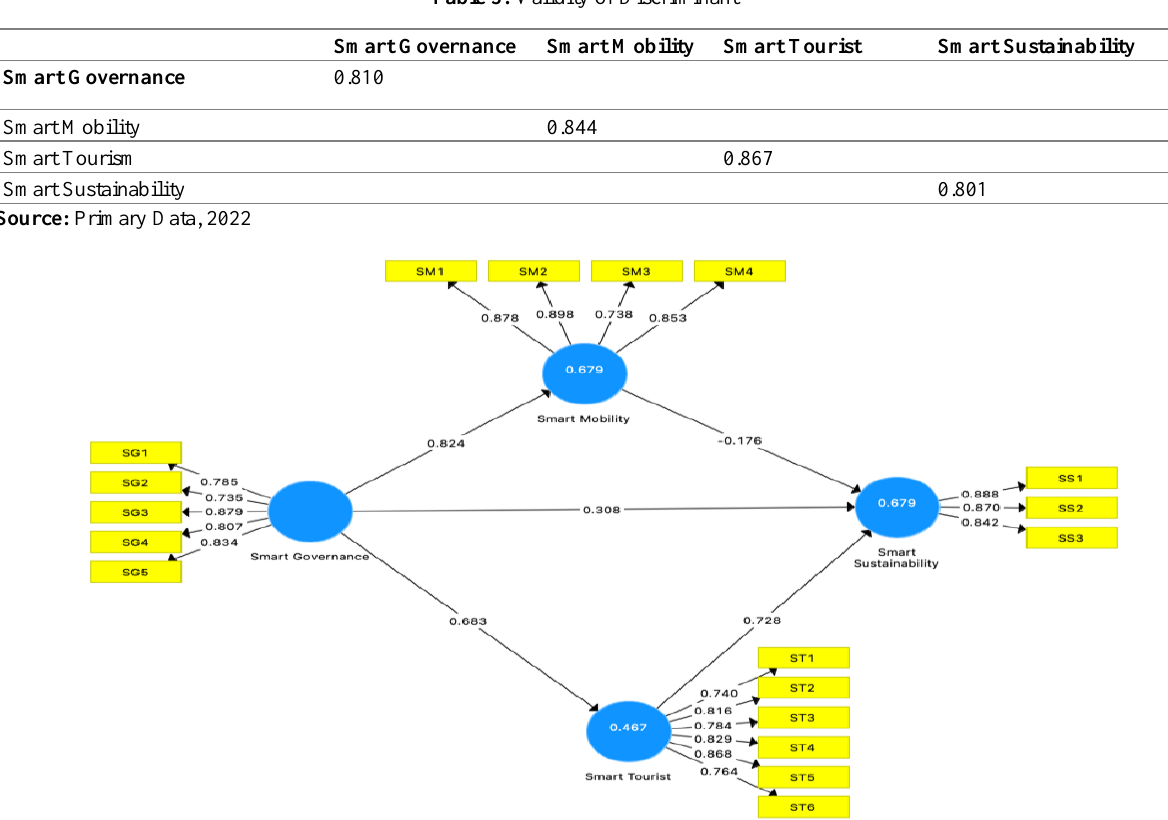
Table 3: Validity of Discriminant